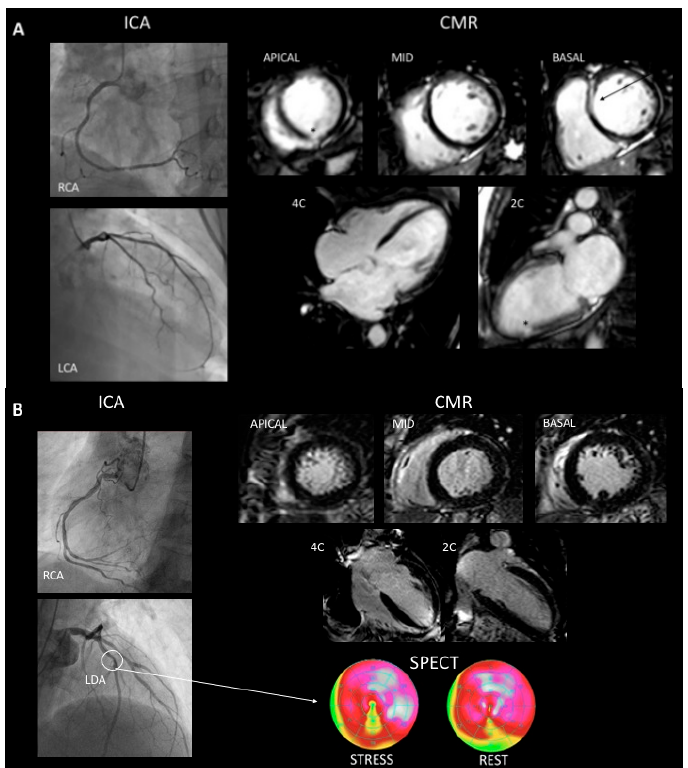
Figure 2. A 66-year-old woman who presented withg dCMP and bystander myocardial infarction. ICA was normal and CMR showed a 31% LVEF, an end-diastolic volume of 131 mL/m 2 , global hypokinesia and 2 patterns of LGE. Mid-wall linear septal (arrow) and small sub-endocardial LGE (asterisk) (Panel A ). A 71-year-old man who presented dCMP with coronary artery disease. ICA shows plaque to 40–50% on left descending anterior artery (arrow), CMR showed a 32% LVEF, an end-diastolic volume of 123 mL/m 2 , global hypokinesia and no LGE (Panel B ). LCA: Left coronary artery, LDA: left descending artery, RCA: right coronary artery, ICA: invasive coronary angiogram, CMR: cardiac magnetic resonance imaging, SPECT: single photon emission computed tomography.